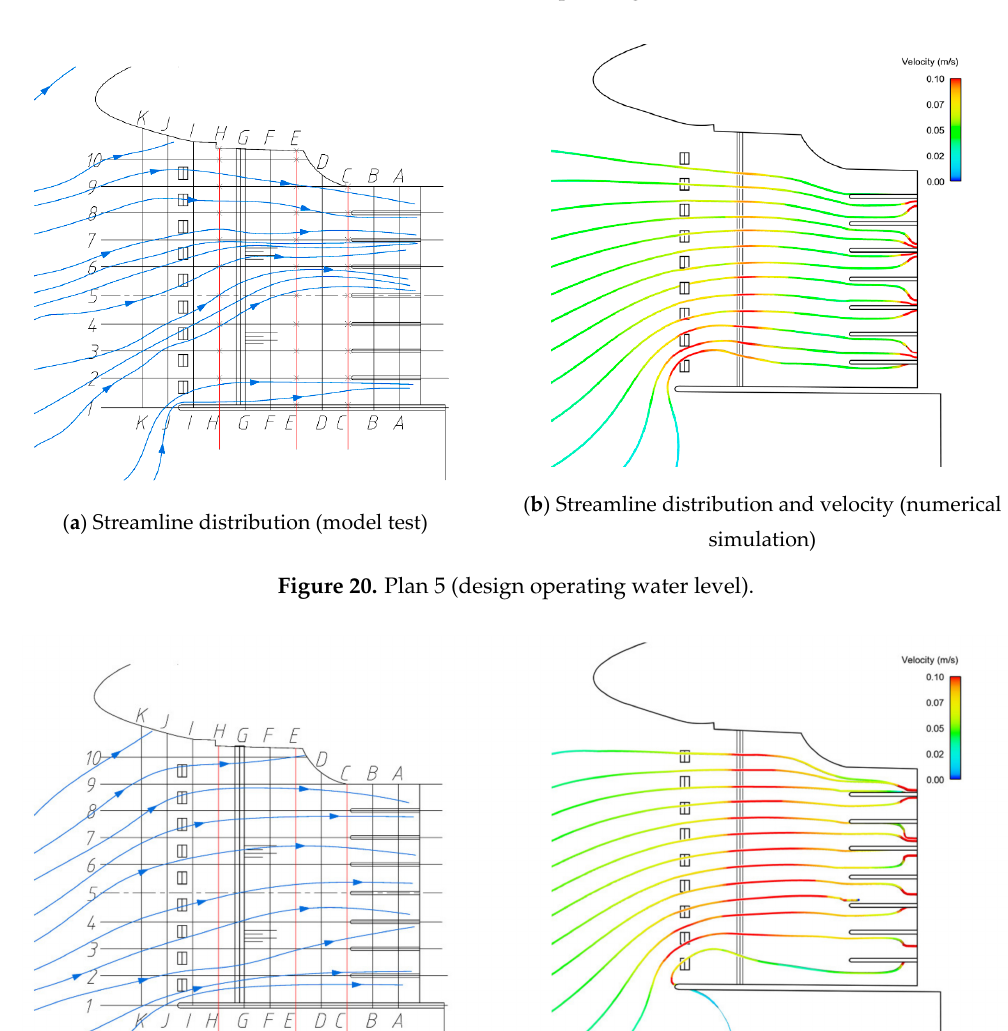
Figure 19. Plan 5 (minimum operating water level).